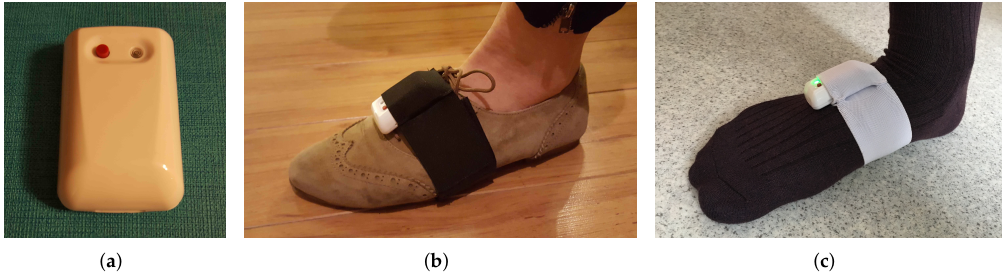
Figure 3. ( a ) ExLs3 IMU, ( b ) strapped to the shoe and ( c ) strapped on the